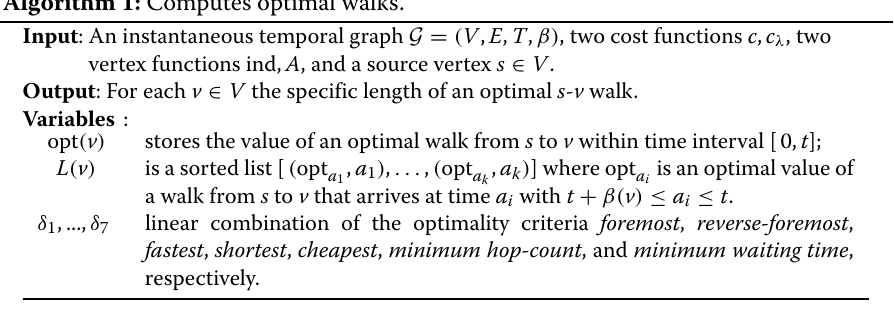
Algorithm 1: Computes optimal